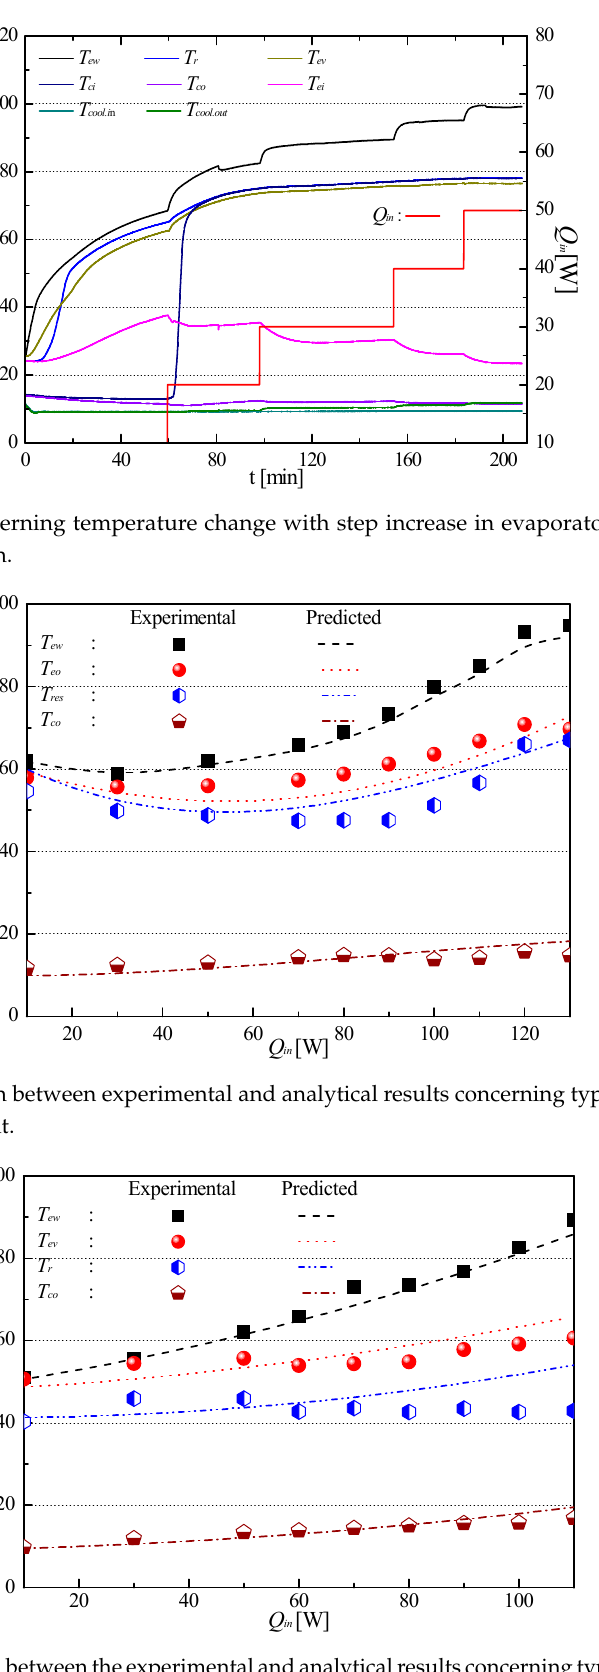
Figure 11. Comparison between the experimental and analytical results concerning typical temperatures at the preferred 7° orientation. at the preferred 7 ◦